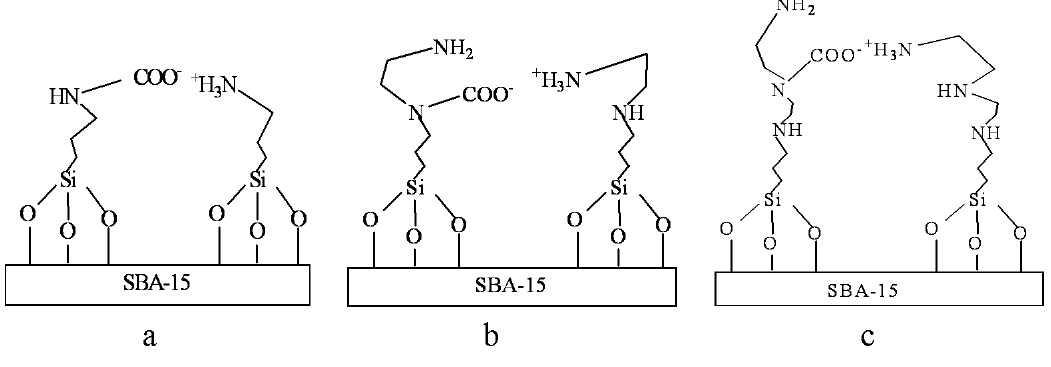
CO adsorption species on different amine-grafted 2